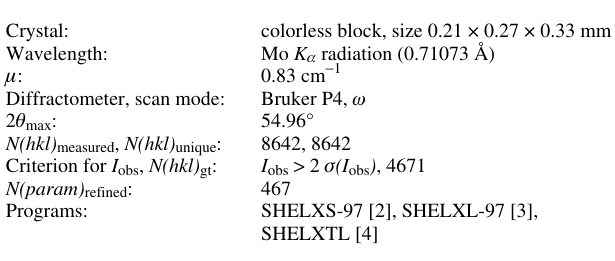
Table 1. Data collection and